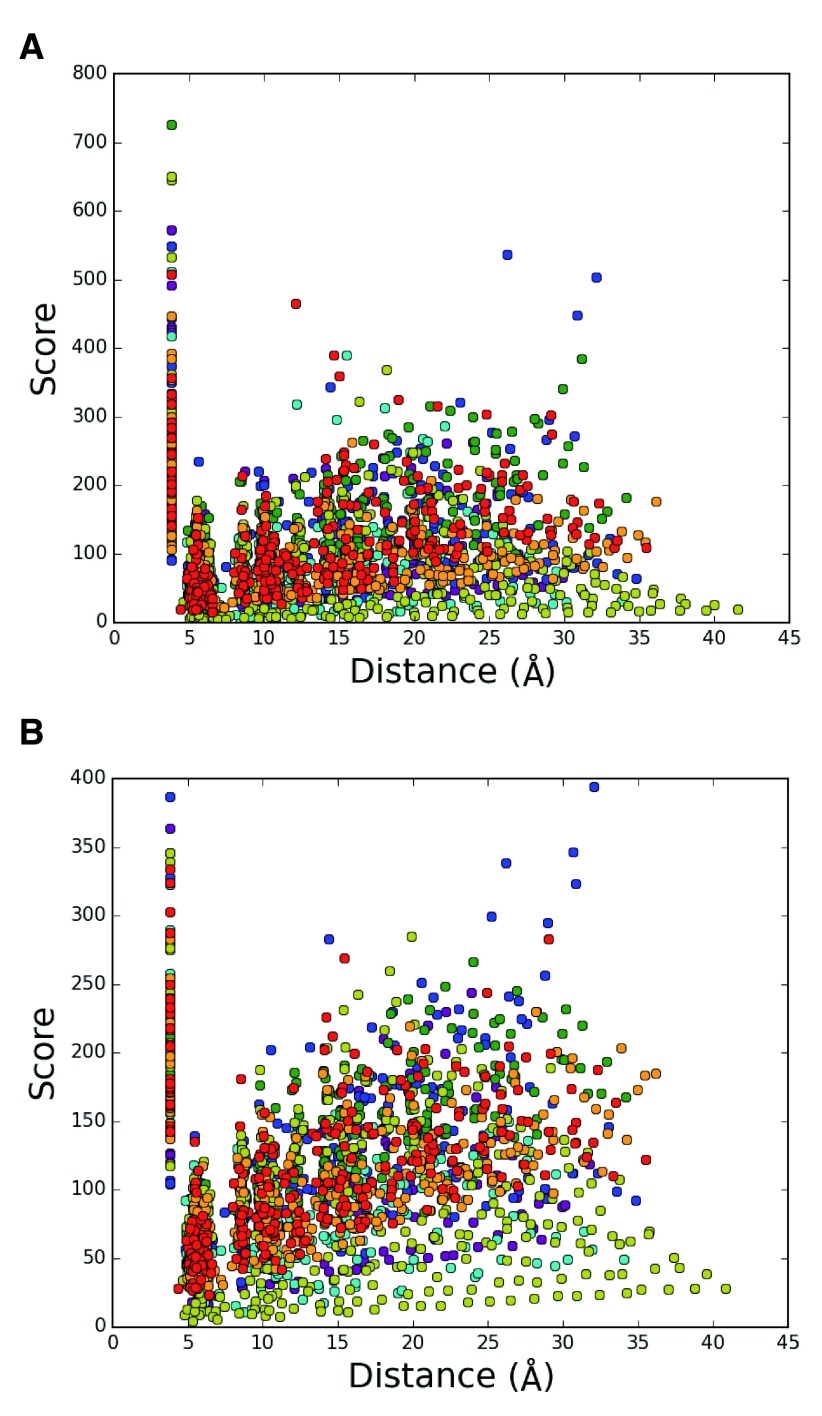
Correlation between score and the average distance for 1,992 intrahelical pairs without a chain obtained from cryo-electron microscopy entry 2AT9 in (
A) set 1 and (
B) set 2, The pairs are colored as follows; purple, helix A; blue, helix B; cyan, helix C; green, helix D; yellow, helix E; orange, helix F; red, helix G.